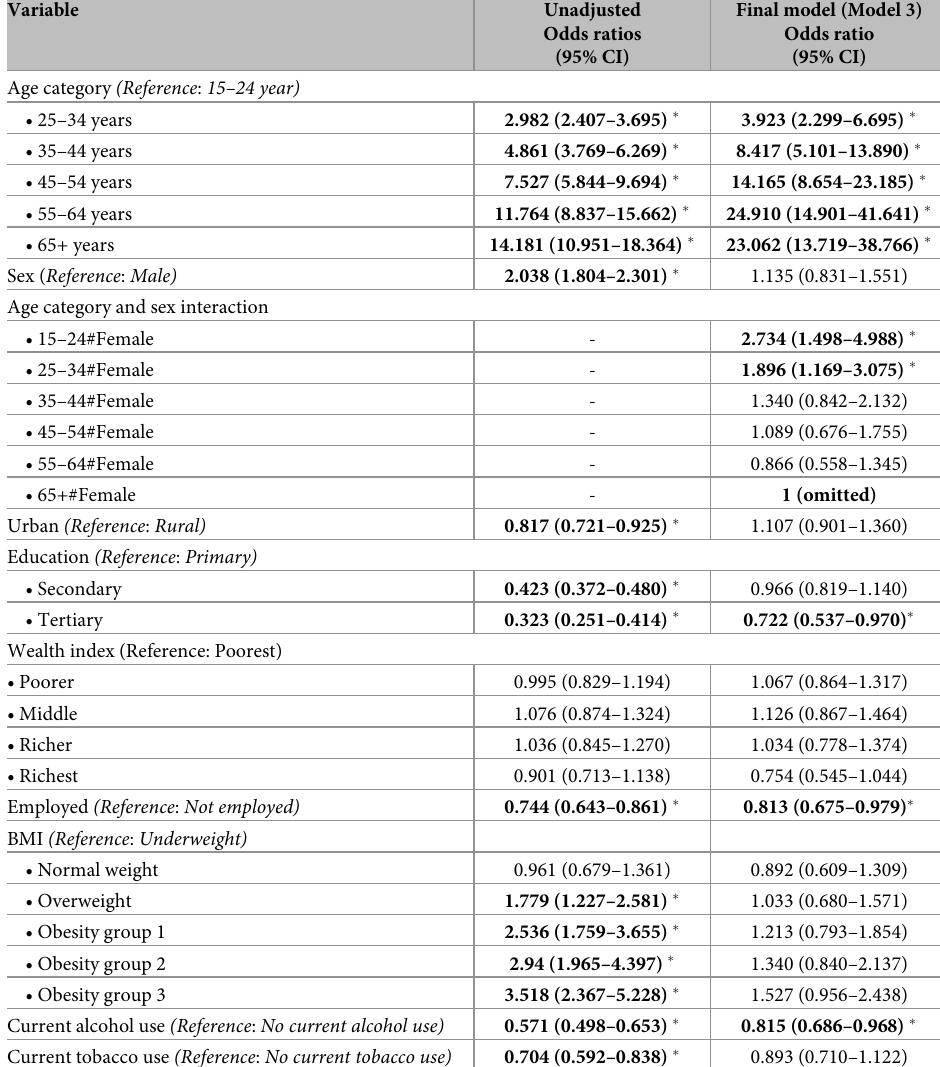
Table 6. Factors associated with